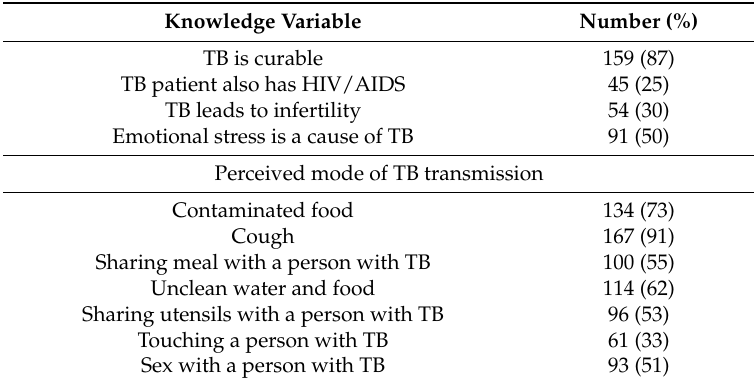
Table 3. Knowledge about TB among community